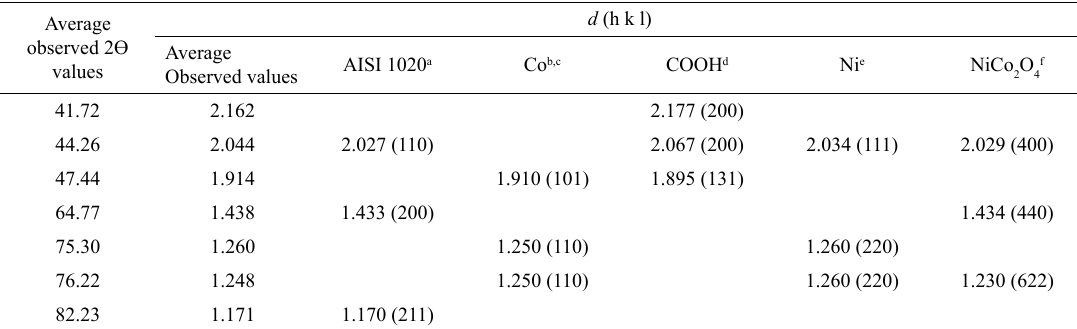
Table 3. d (h k l) values for the coatings produced using Solutions 1 and 2 Average observed 2ϴ